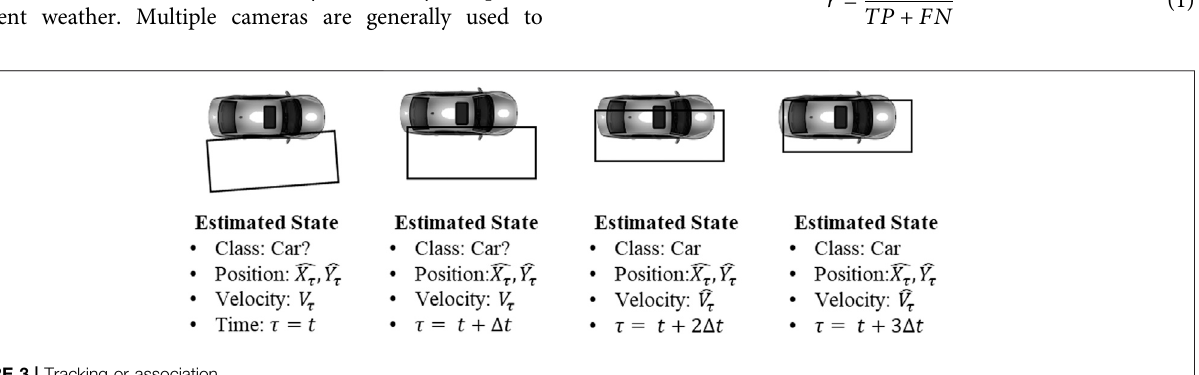
FIGURE 3 | Tracking or